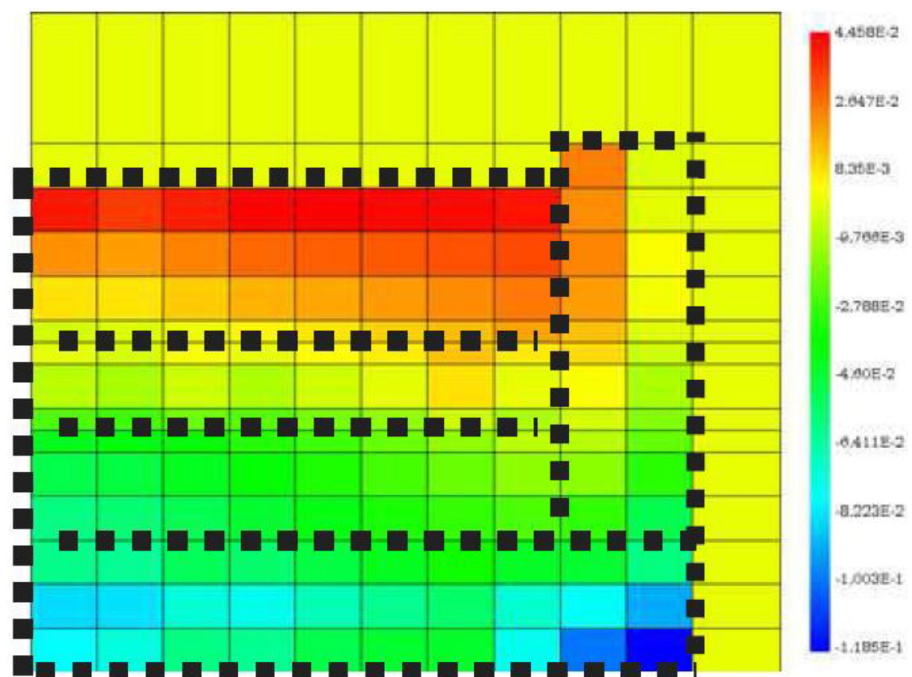
Fig. 4. ASTRID reactor (cid:1) Fissile+ fertile partition into 132 regions (cid:1) Sensitivity of the fi ssion source distribution to the 56 Fe elastic